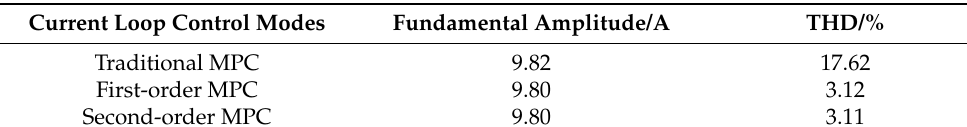
Table 4. Current analysis of the three current loop control algorithms.